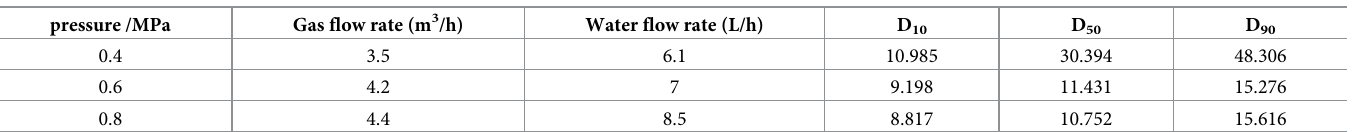
Table 4. Nozzle atomization characteristics.